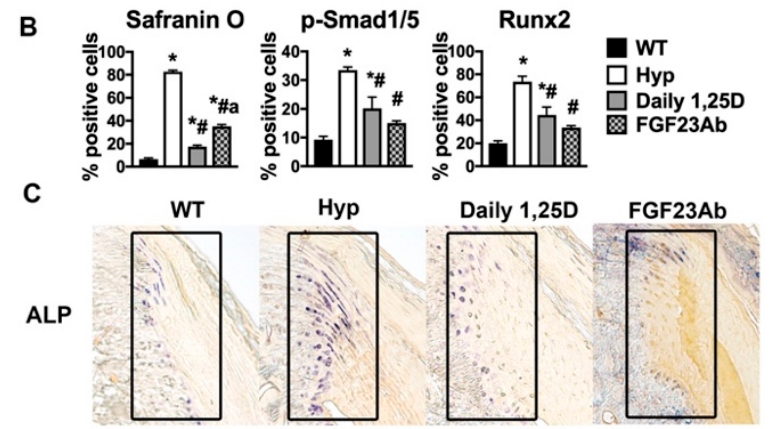
Figure 2. Treatment of Hyp mice with 1,25D or FGF23Ab starting early post-natally (P2) prevents enthesopathy: Hyp mice were treated with daily 1,25D or FGF23Ab 3x per week from post-natal day (P) 2 to P30 and Achilles entheses harvested. Hyp enthesopathy is characterized by increased bone morphogenic protein (BMP) and Indian hedgehog (IHH) signaling and alkaline phosphatase (ALP) activity in Achilles entheses, where either 1,25D or FGF23Ab treatment of Hyp mice is able to prevent development of enthesopathy. ( A ) Safranin O (SafO) stain, immunohistochemistry (IHC)